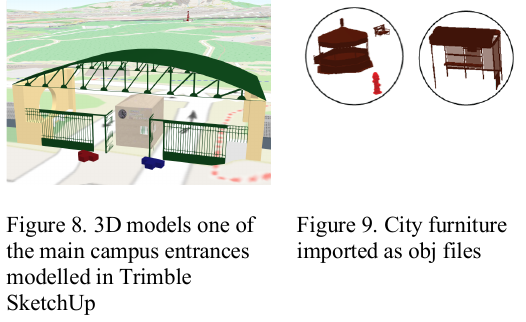
Figure 8. 3D models one of